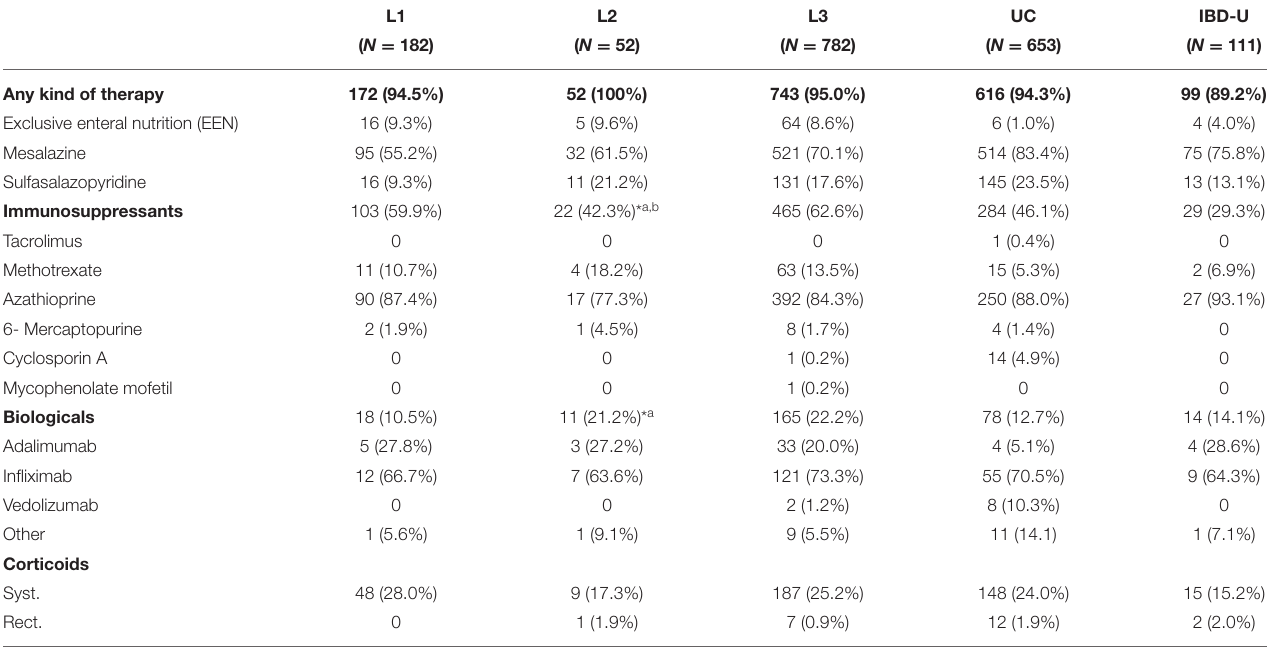
TABLE 4 | Treatments of the respective disease groups in the course after induction therapy. L1